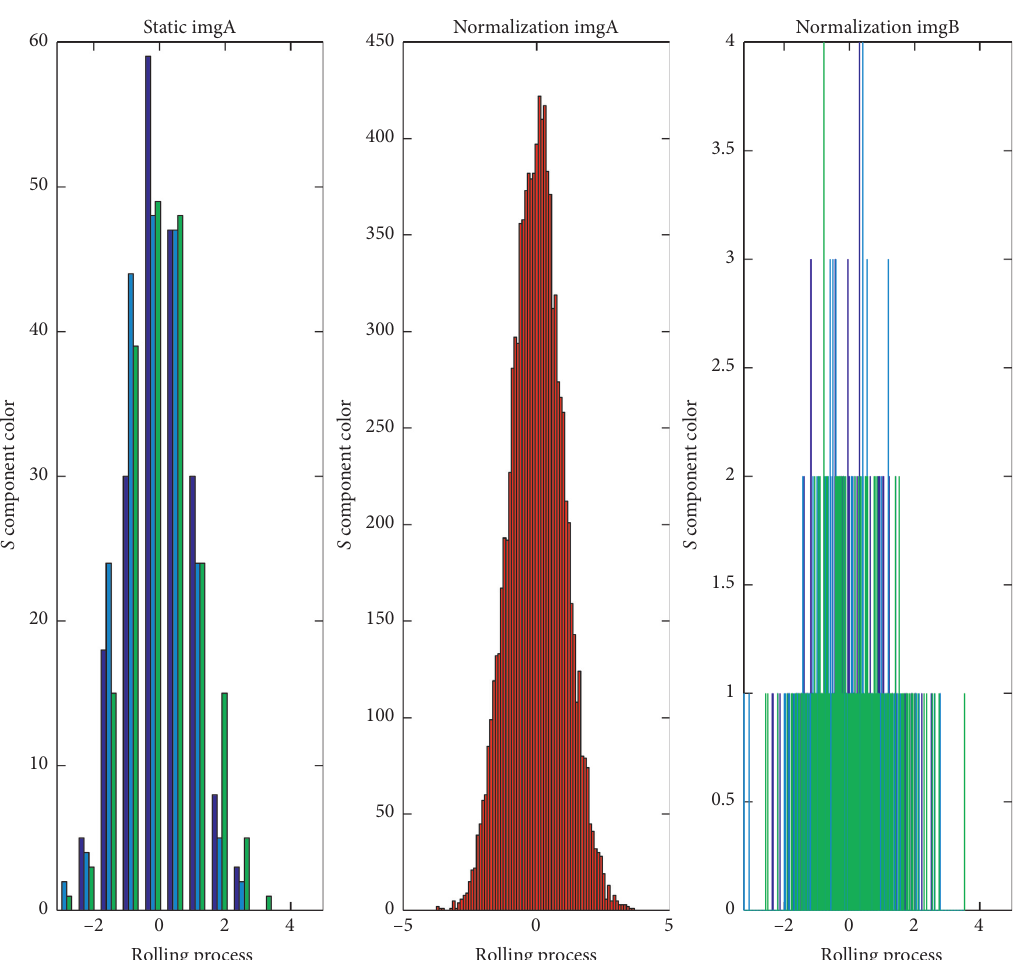
Figure 6: Color histogram and normalized color histogram of the